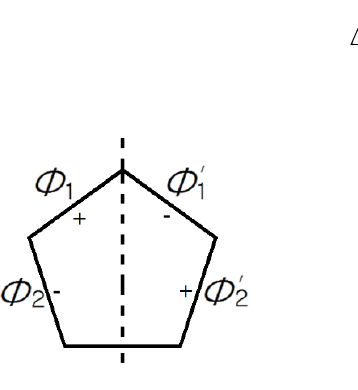
Figure 5. ΔCs related torsion angles in five membered rings. Figure 5. ∆ Cs related torsion angles in five membered rings. Table 1. Conformational ΔC s parameter describing the rings 6c and 6b . Table 1. Conformational ∆ C s parameter describing the rings 6c and 6b